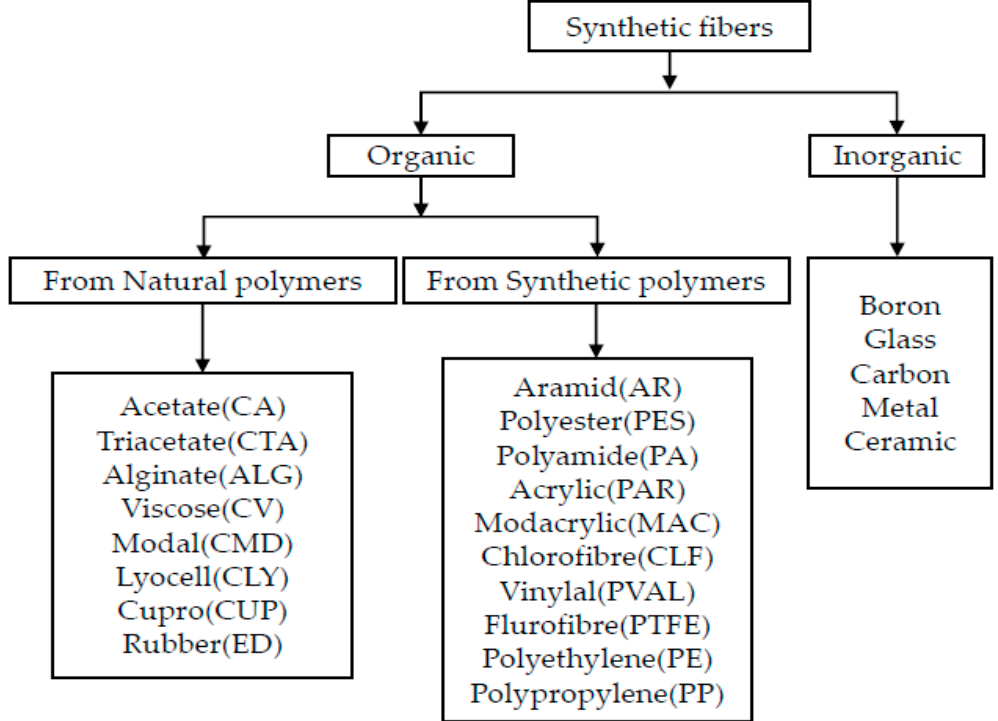
Figure 5. Classification of synthetic fibers [15].